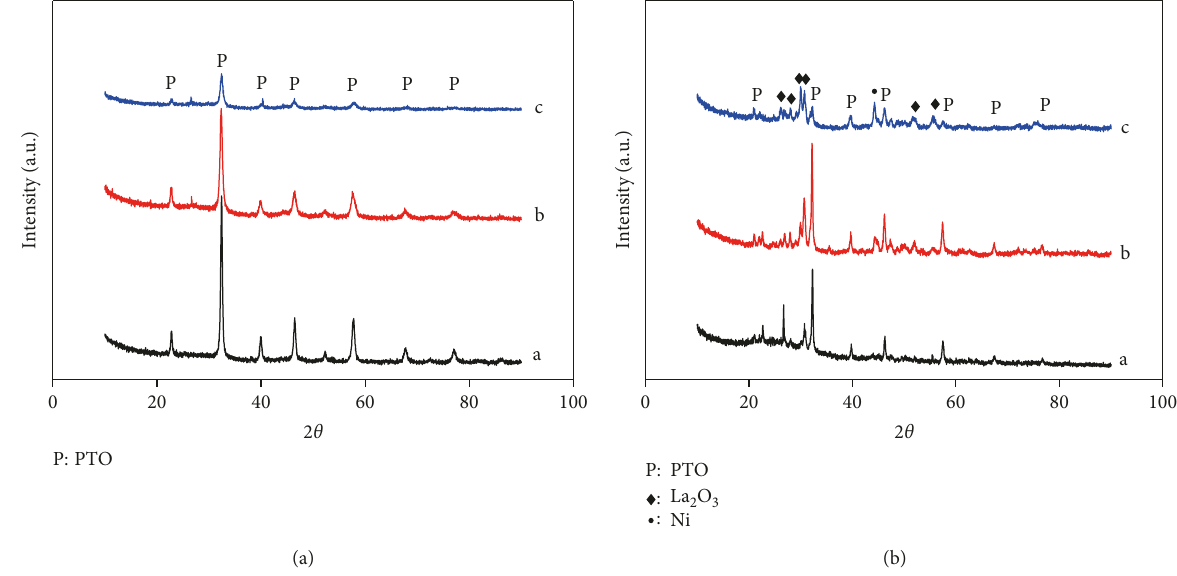
Figure 4: XRD patterns of (a) LaFe ° C for 2h in 5%H 1 − x Ni x O 3 after reduction at 600 2 /95%Ar and (b) after the MDR reaction. (a) LaFe 0.7 Ni 0.3 O 3 , (b) LaFe 0.5 Ni 0.5 O 3 , and (c) LaFe 0.3 Ni 0.7 O 3